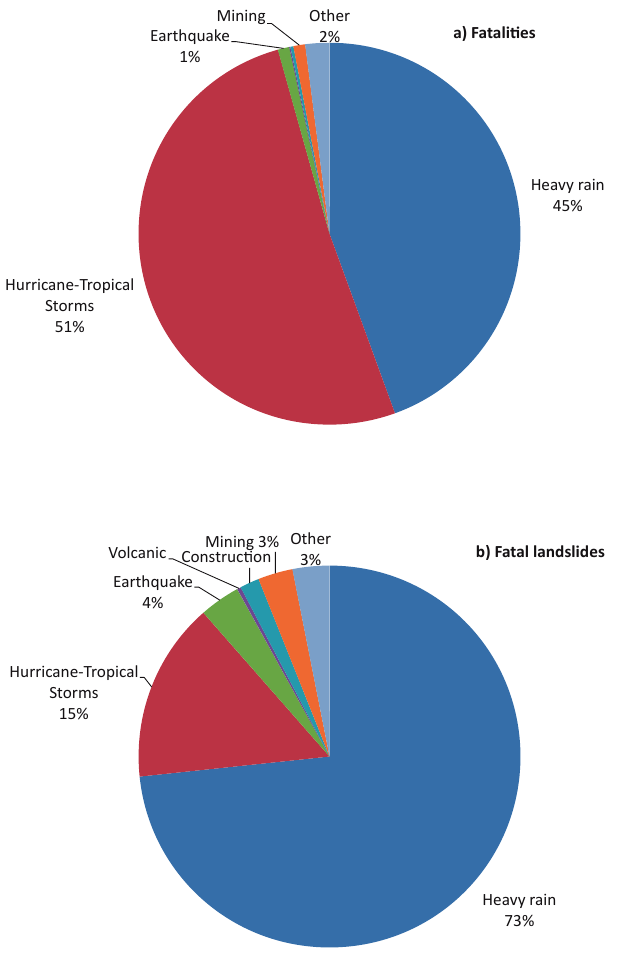
FIGURE 3 Figure 3. Main triggers of fatal landslides in the studied period.